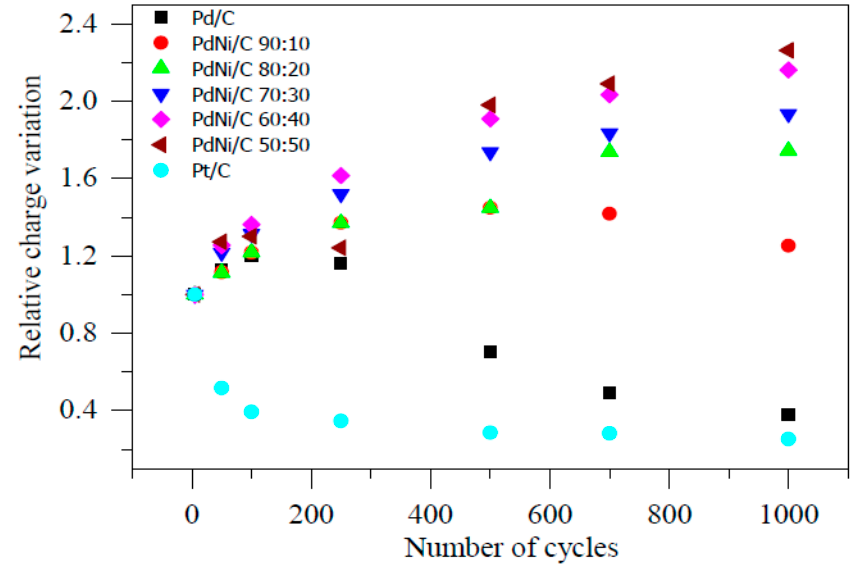
Figure 11. Relative charge variations during accelerated stability tests in 0.1 M NaOH.